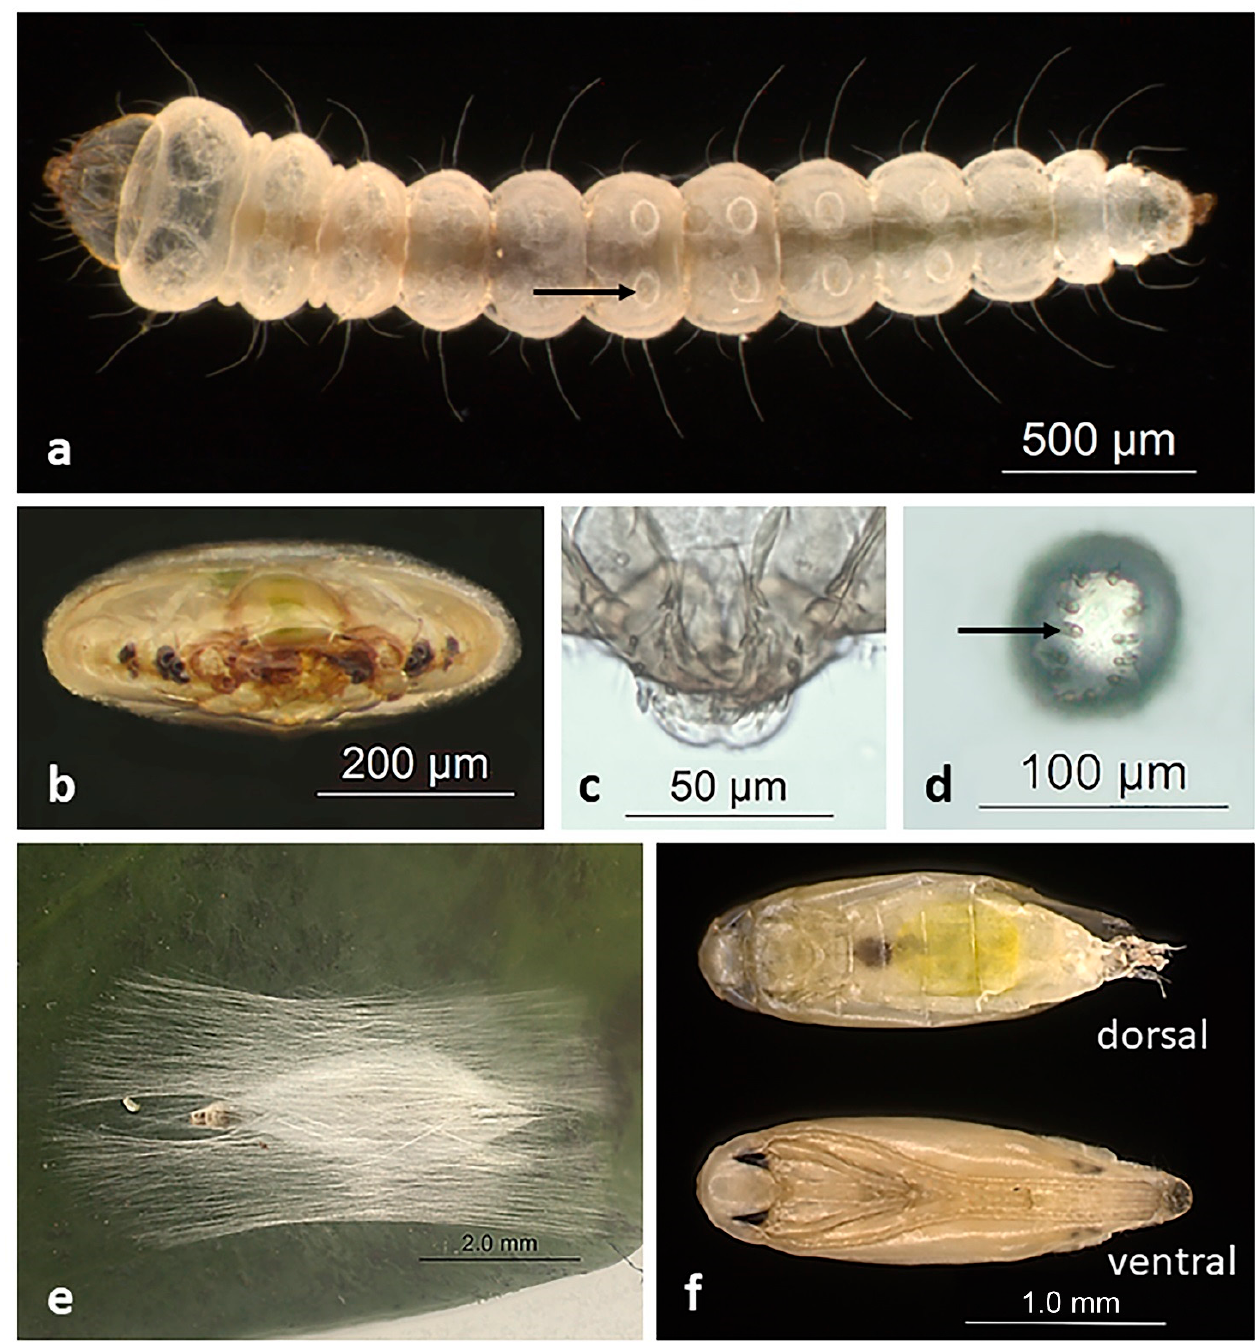
Figure 4. Immature stages of L. coffeella . ( a ) Ventral view of a fourth instar larva. Arrow indicates proleg; ( b ) flat head in front view; ( c ) chewing mouthpiece; ( d ) crochets (arrow) located in proleg. Morphology details to distinguish the immature stages are described in the text; ( e ) pupa’s sea cocoon; ( f ) pupae’s dorsal ( a ), and ventral ( b ) shapes.